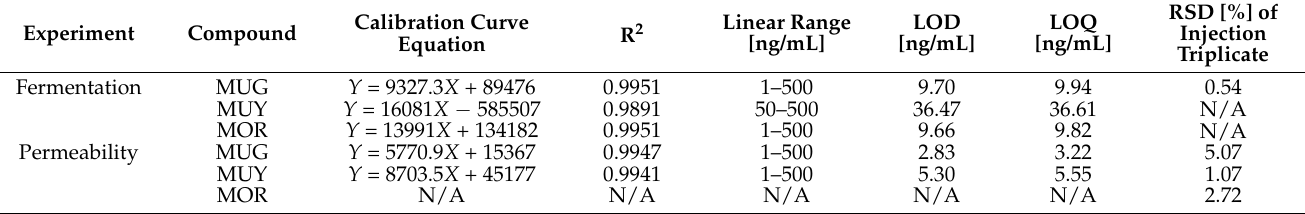
Table A1. Limit of detection (LOD) was calculated as signal to noise ratio 3:1, limit of quantification (LOQ) was calculated as signal to noise ratio 10:1. N/A = not available. For the apical side of the permeability assay, the LOD and LOQ were 10-fold higher due to aliquot sampling.